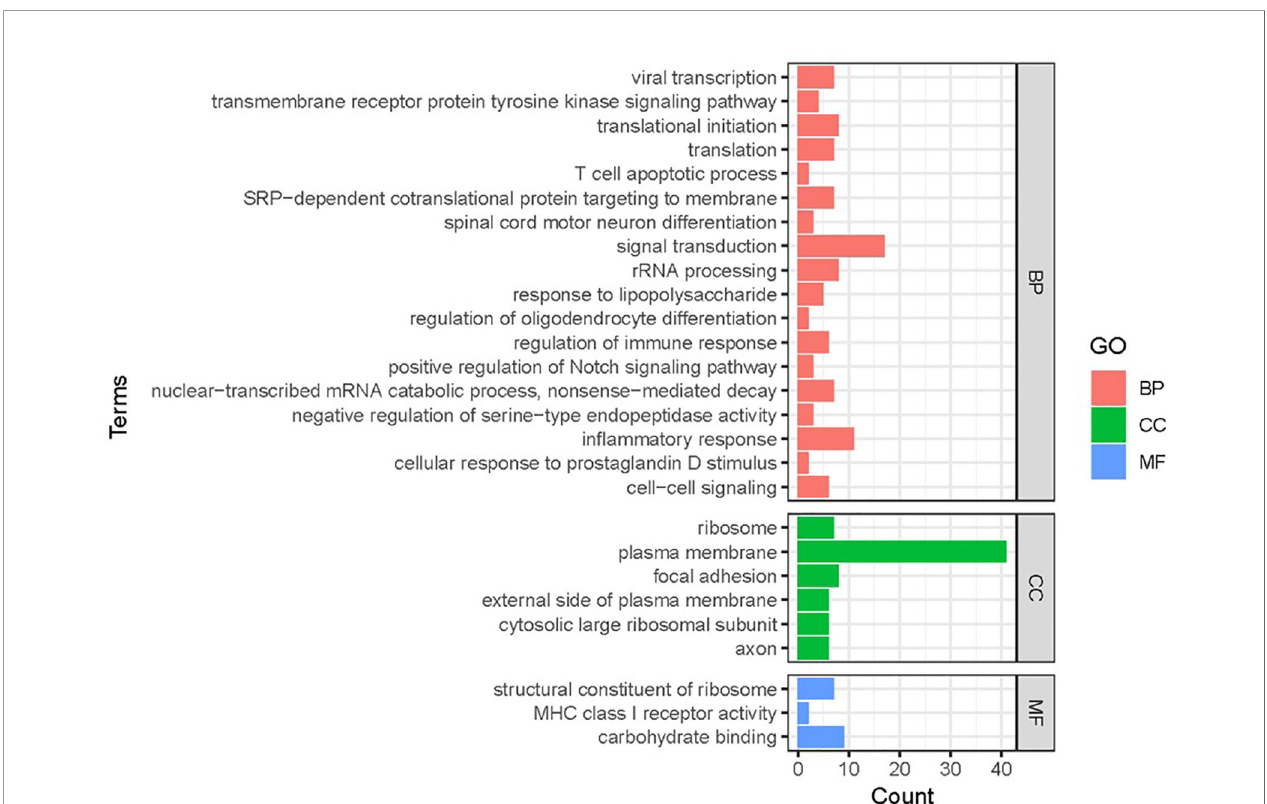
FIGURE 2 | Gene functional classi fi cation of DEGs in RSV-infected children. BP, biological processes; CC, cellular compartment; MF, molecular function. Note that most DEGs belonged to “ ribosomal processing ” and “ immune-related signaling ” .